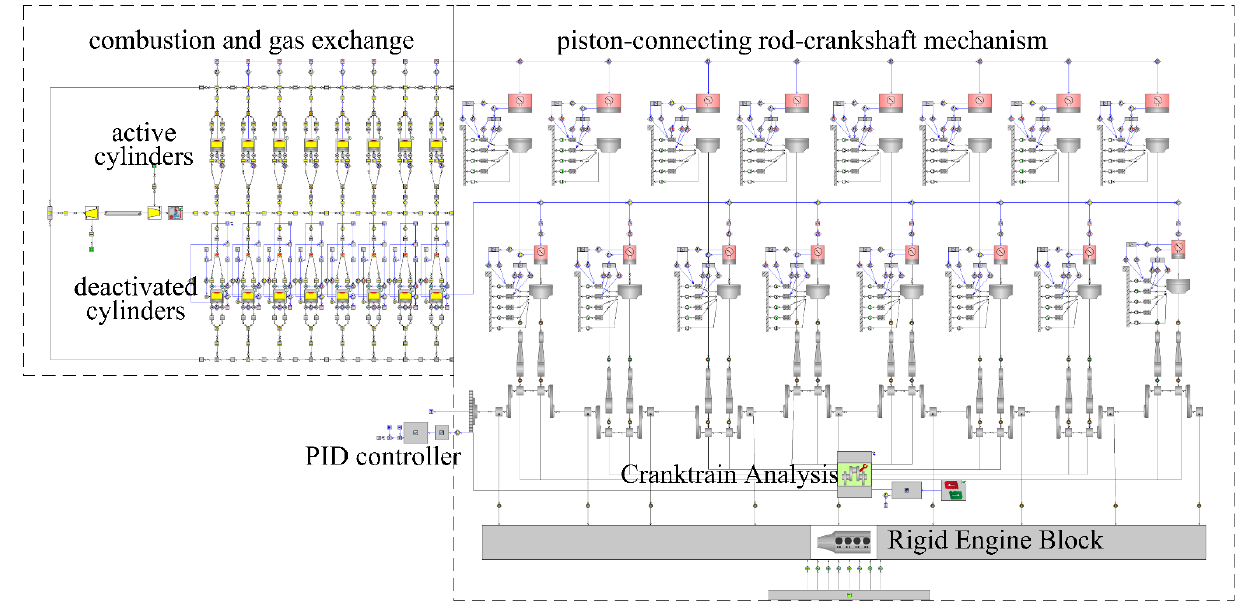
Figure 1. Constructed engine model of the diesel engine D-49.